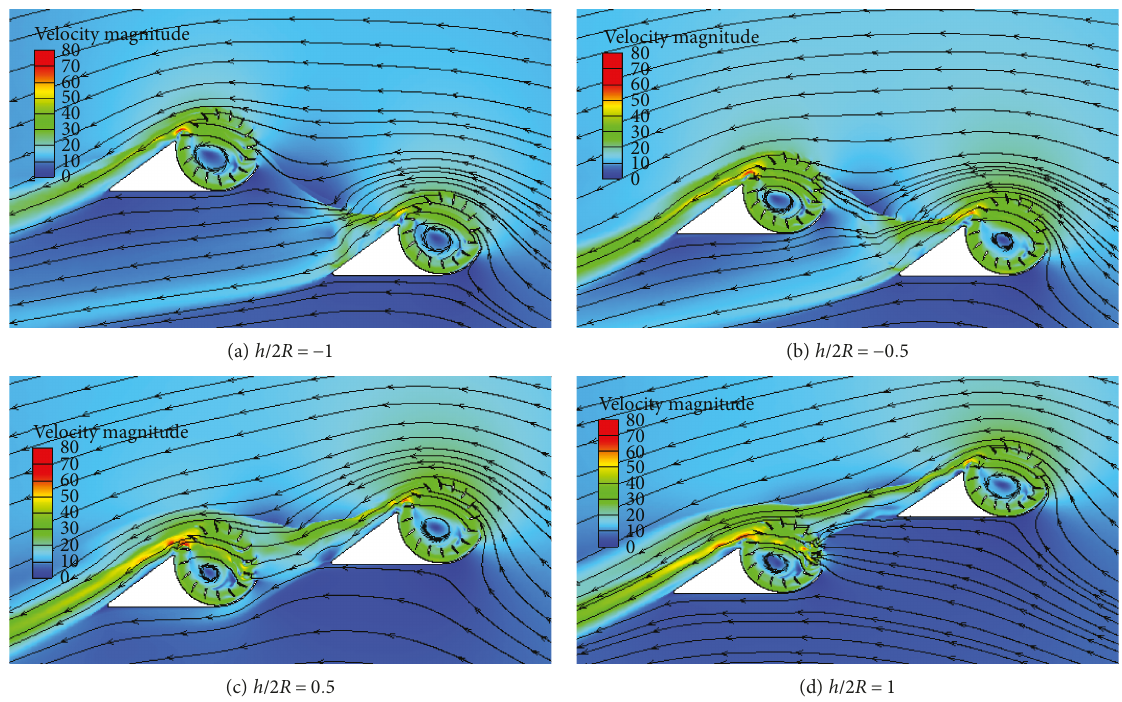
Figure 10: Velocity contours and streamlines of the height change between the front and rear wings of the tandem fan